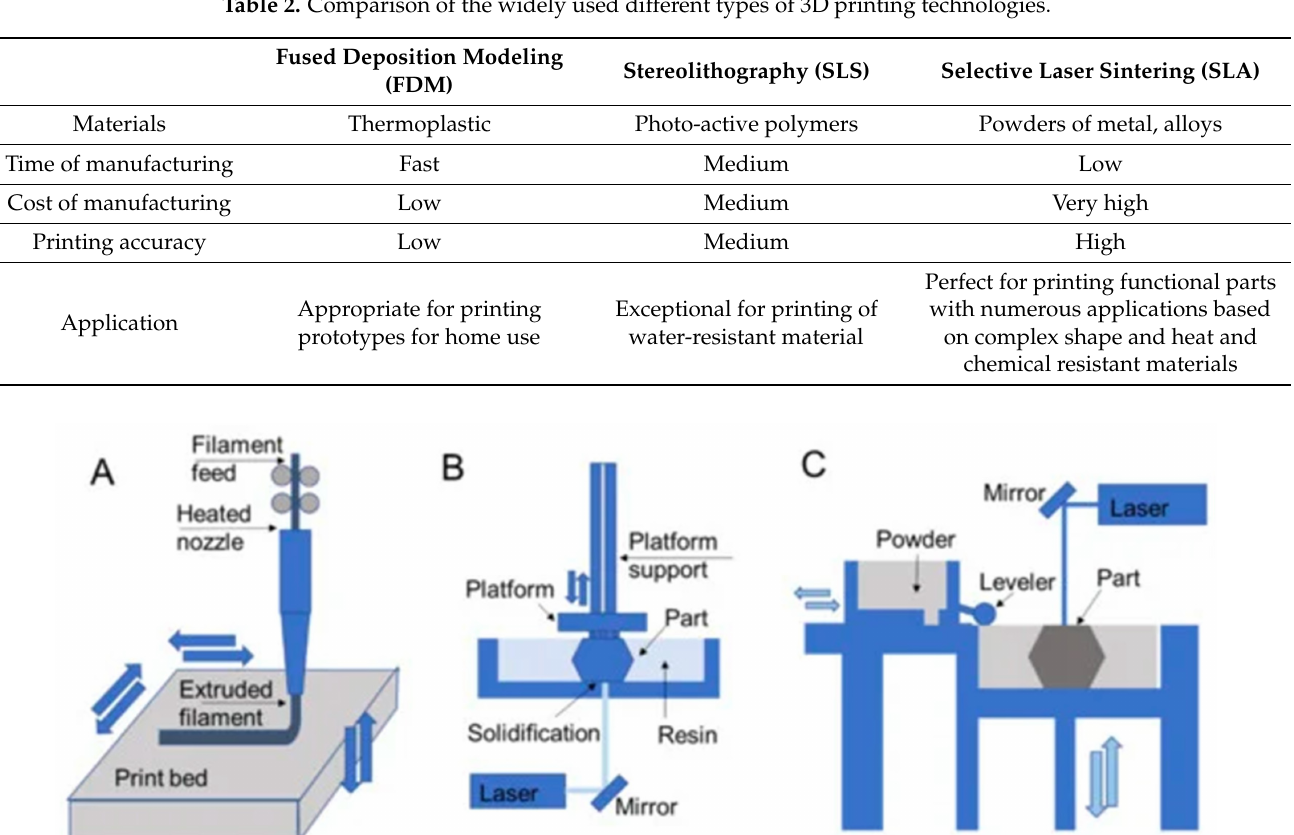
Figure 2. Three-dimensional printing schematics for ( A ) fused deposition modeling, ( B ) stereolithography, and ( C ) selective laser sintering that are representative of extrusion, resin, and powder processes, respectively. Reprinted with permission from Ref [42] Copyright 2020 by the authors and license MDPI, Basel,